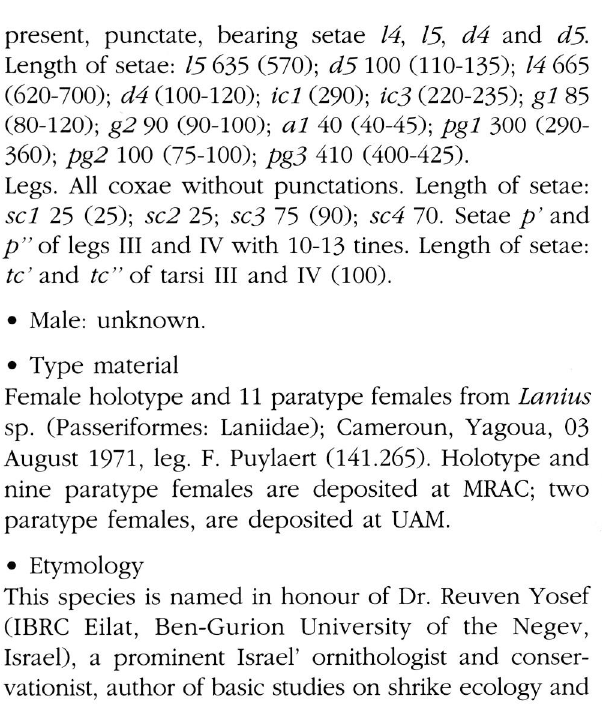
Figs 7-9. - Syringophilopsis kristini sp. n. Female. 7. Hypostomal apex ventral view. 8. Hypostomal apex dorsal view. 9. Peritreme. Figs 10, 11. - Syringophilopsis kristini sp. n. Male. 10. Hypostomal apex ventral view. 11. Peritreme. Figs 12, 13. - Syringophilopsis yosejHi sp. n. Female. 12. Hypostomal apex ventral view. 13.